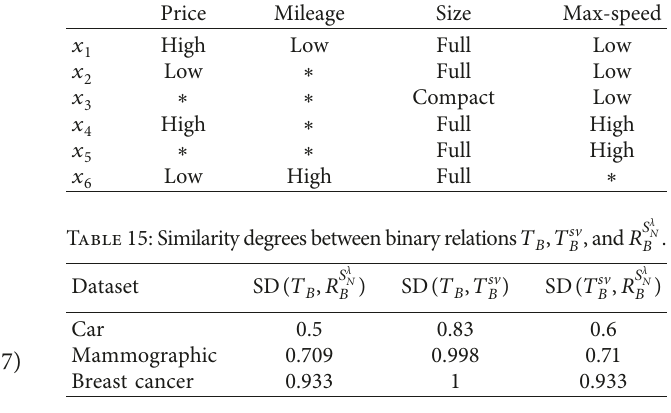
Table 16: The entropies of T